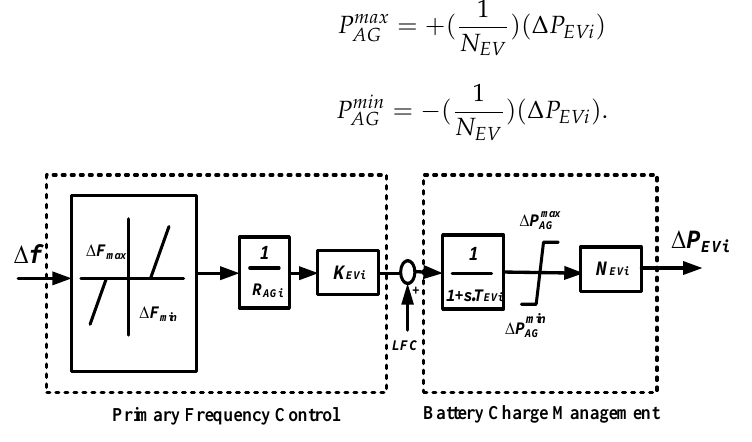
Figure 7. Simulation model of